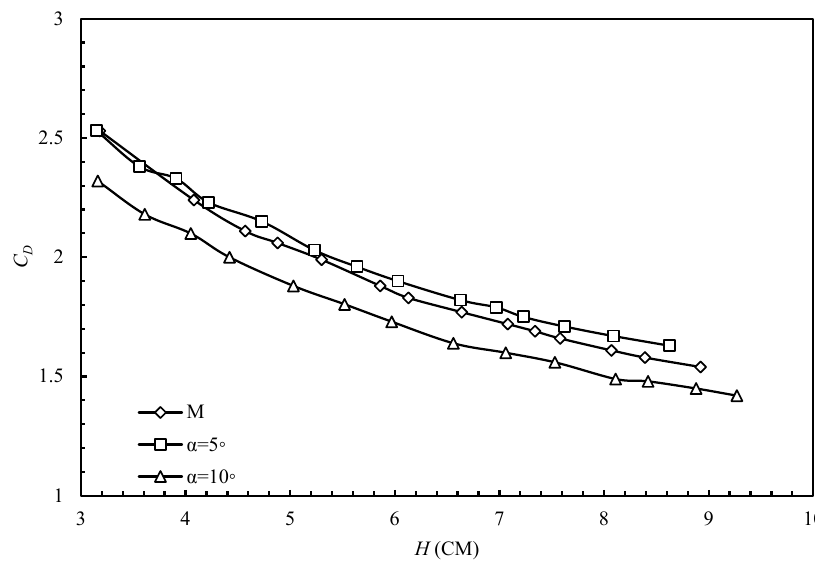
Figure 10. Variation of C D with H .